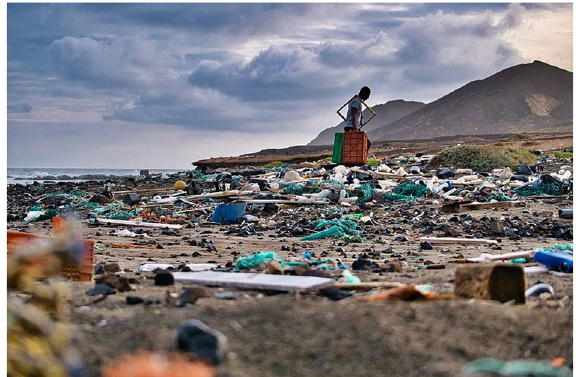
Fig. 9 Plastic Pollution in Santa Luzia, Cape Verde (source: Wikimedia Commons the image is used under a CC BY-SA 4.0